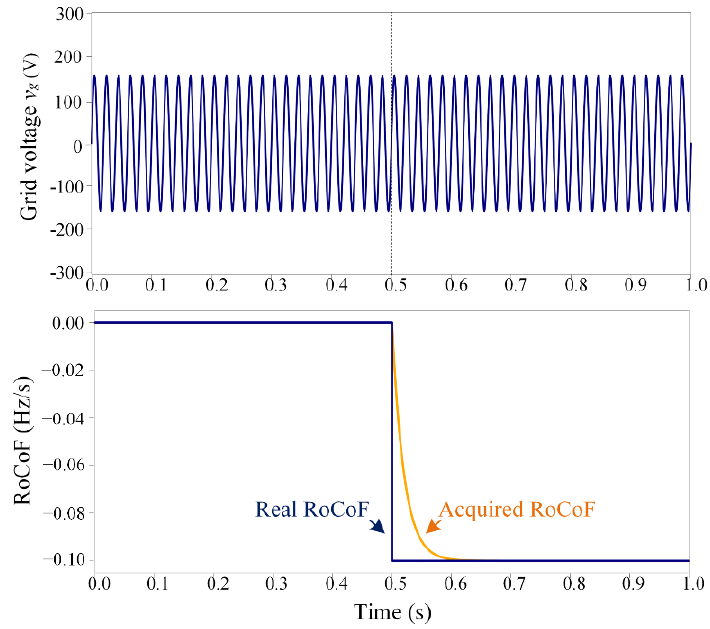
Figure 8. Simulation results for RoCoF acquisition.